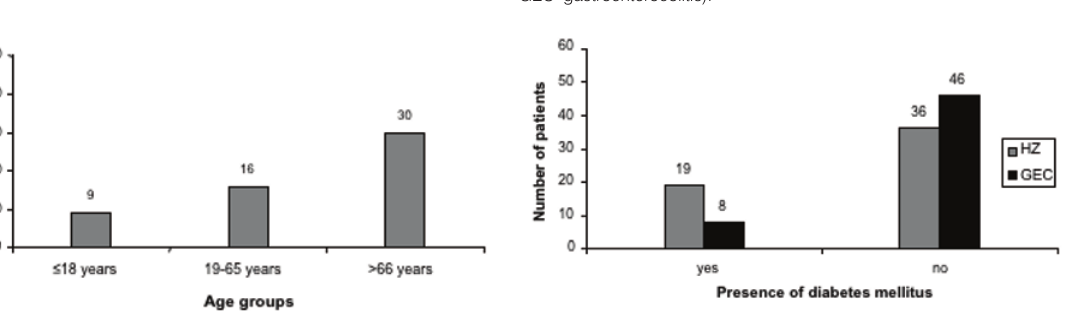
Figure 1. The incidence of herpes zoster based on the age of the patients presented with herpes zoster, the Clinic for Infectious Diseases UCH Mostar in the period from January, 1st 2005 to October, 31st 2010.